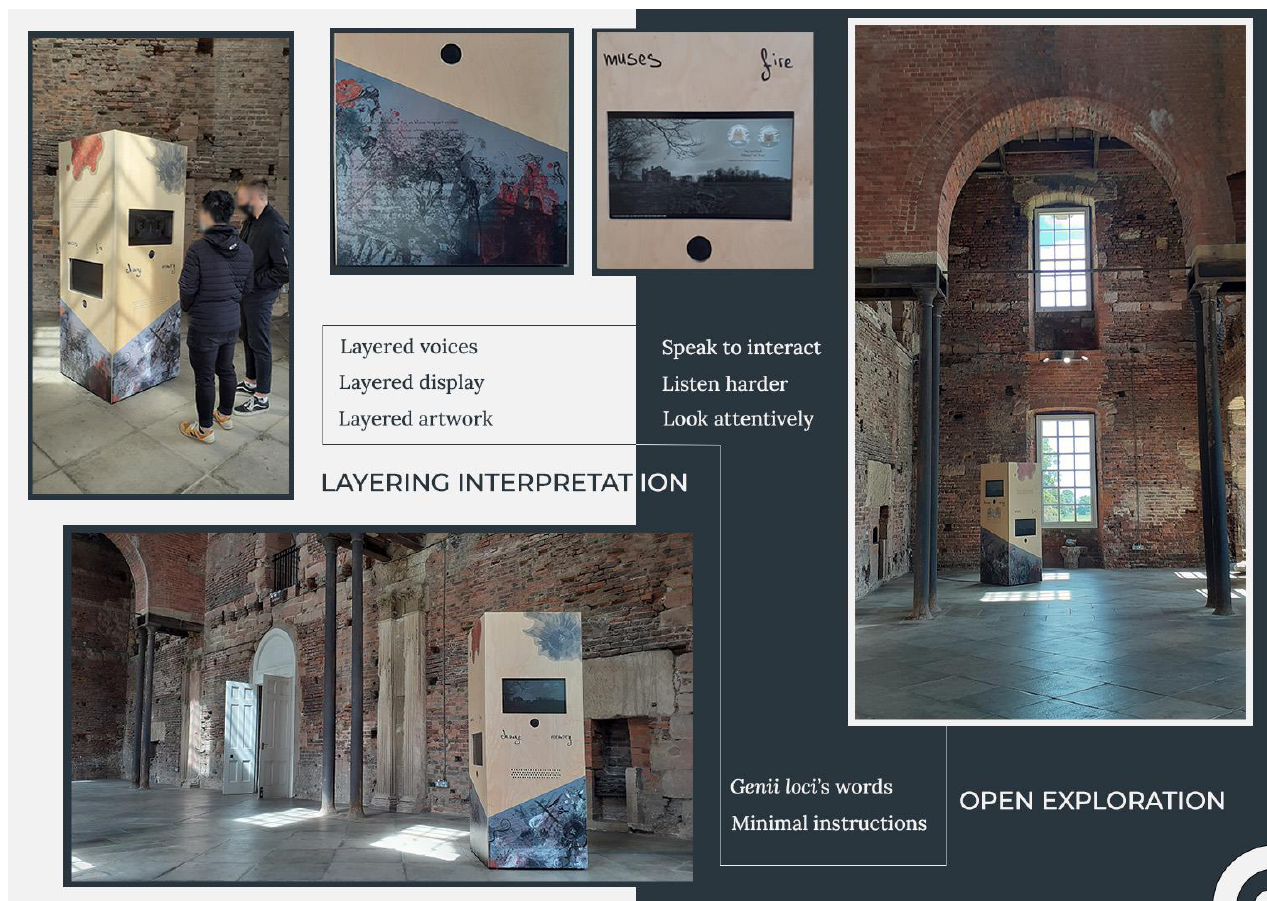
Figure 9. Loci Stories Design Domains and Interaction Qualities.